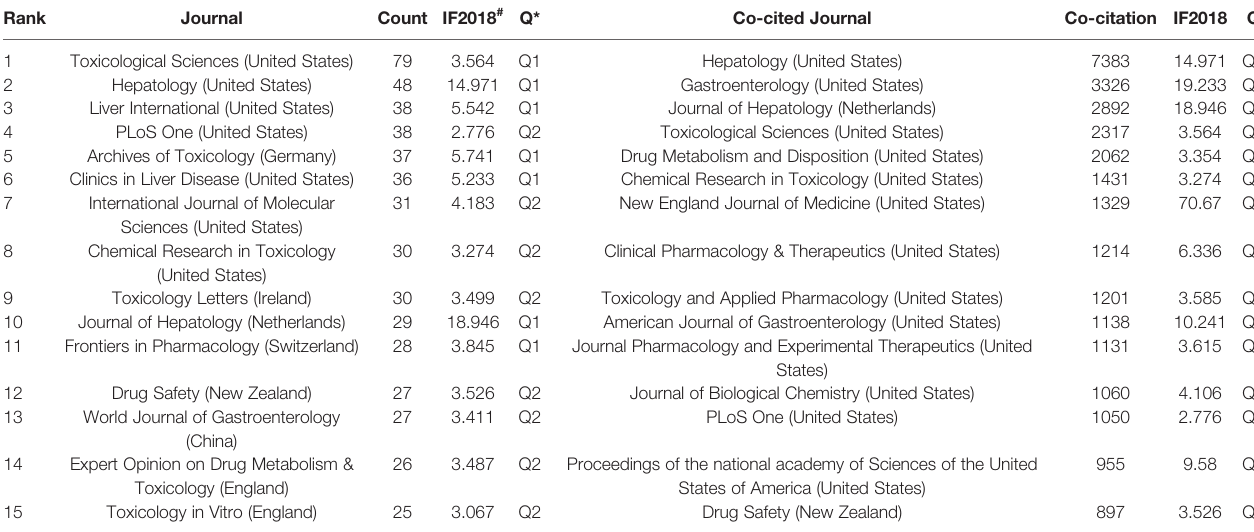
Figure 6A . The node sizes of Watkins PB and Fontana RJ are